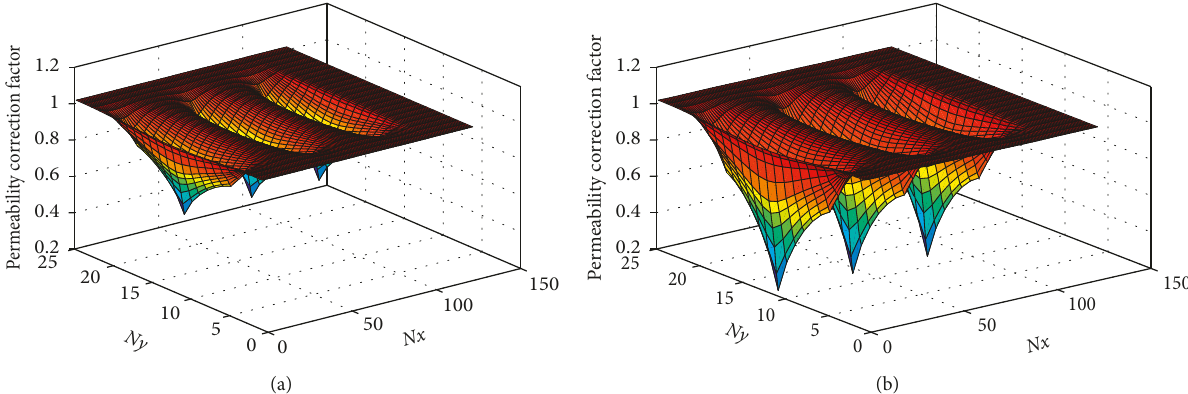
Figure 15: Distribution of the permeability correction factor after 500days: stress sensitivity coefficient equals (a) 0.03MPa